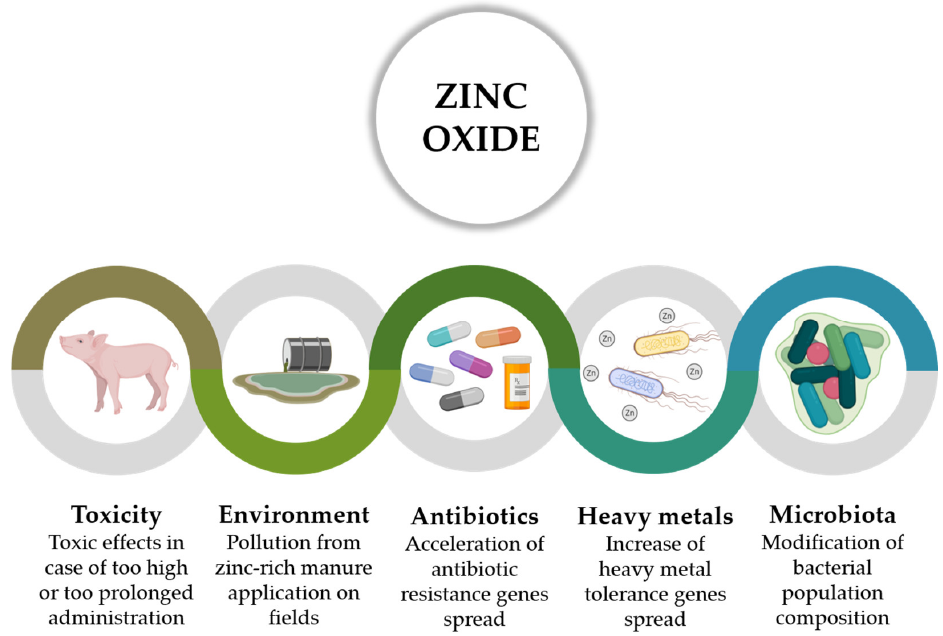
Figure 2. Risks related to pharmacological zinc oxide utilization in post-weaning piglets.